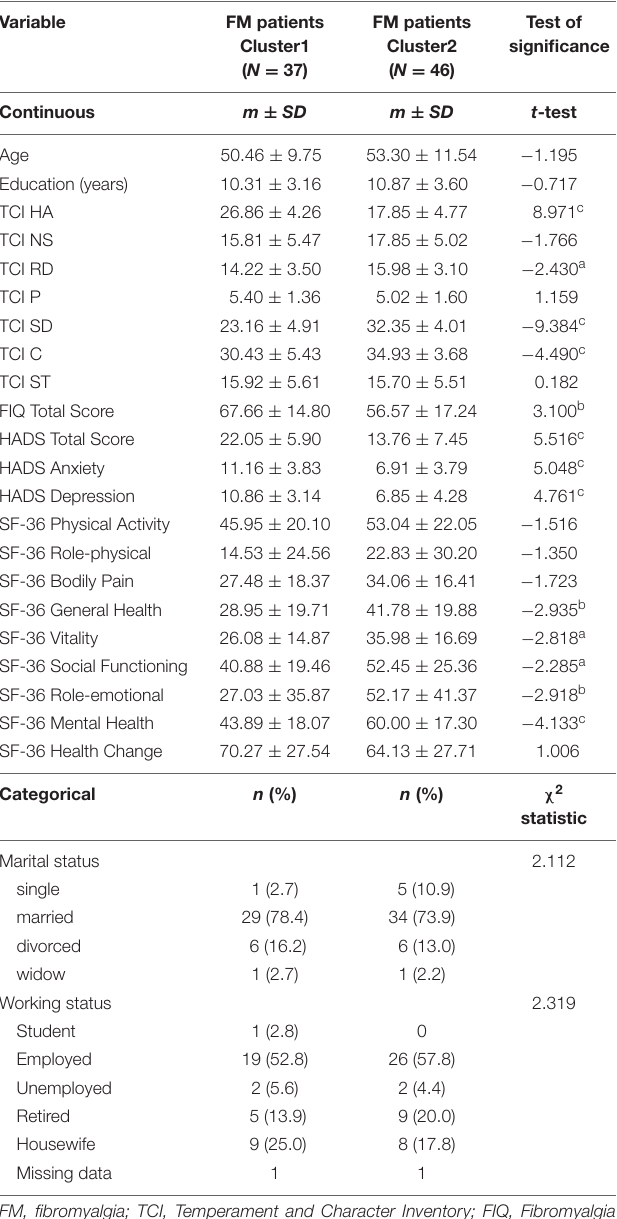
TABLE 2 | Demographics, personality characteristics, fibromyalgia severity, anxiety, depression and health-related quality of life: cluster